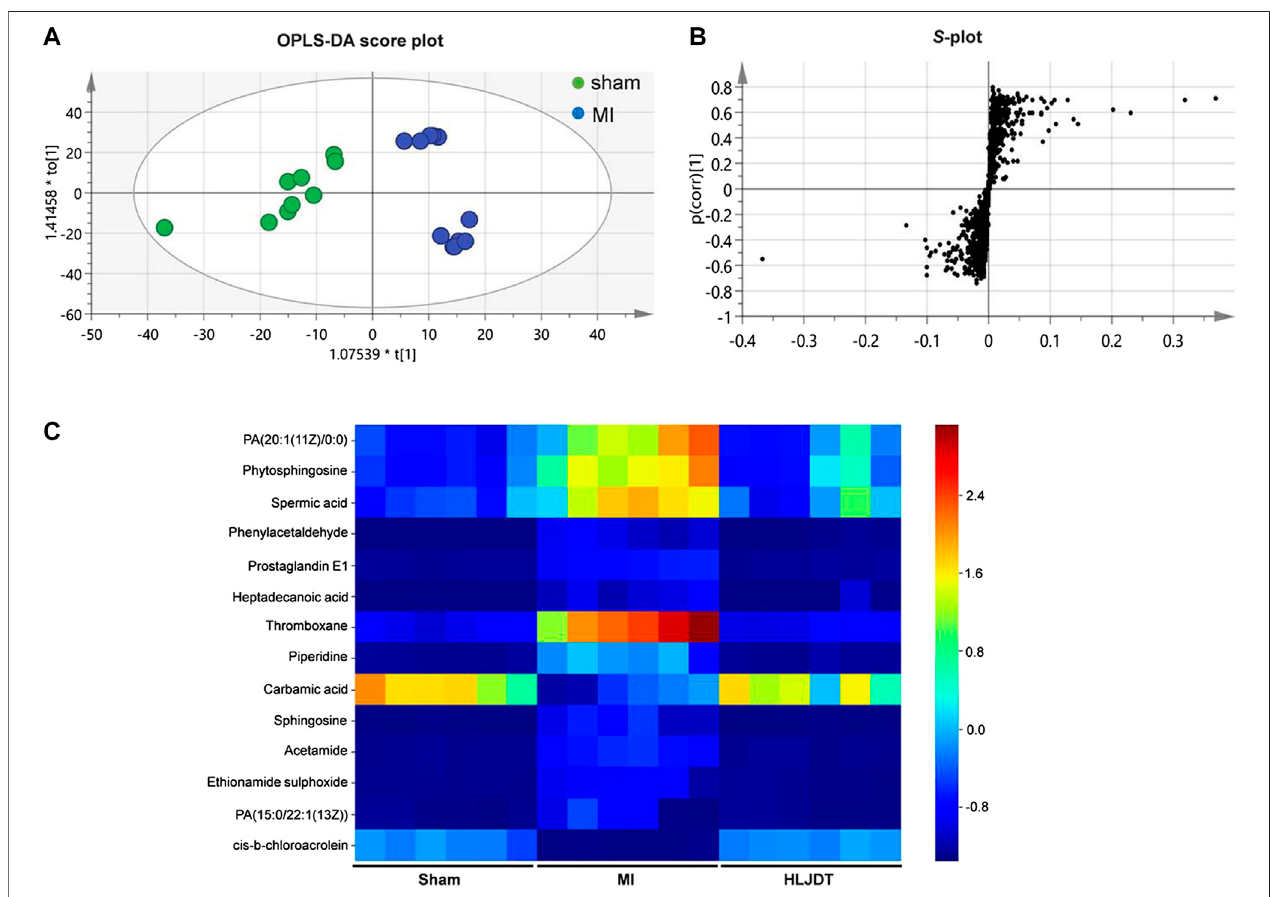
FIGURE 7 | Metabolic data analysis of serum by UPLC-Q-TOF/MS (A) OPLS-DA score plot of serum samples from sham and MI model rats in positive mode (B) S-plot from OPLS-DA of serum samples from sham and MI model rats in positive mode (C) Comparison of normalized mass spectrometric peak intensities for potential biomarkersindifferentgroups.Potentialbiomarkersweredeterminedbytheconditionoffoldchangeslargerthan1.5, p valueslessthan0.05,andVIPvalueslargerthan 2.0. They were PA (20:1 (11Z)/0:0), phytosphingosine, spermic acid 2, phenylacetaldehyde, prostaglandin E1, heptadecanoic acid, thromboxane, piperidine, carbamic acid, sphingosine, acetamide, ethionamide sulphoxide, PA (15:0/22:1 (13Z)), and cis -3-Chloroallyl aldehyde.